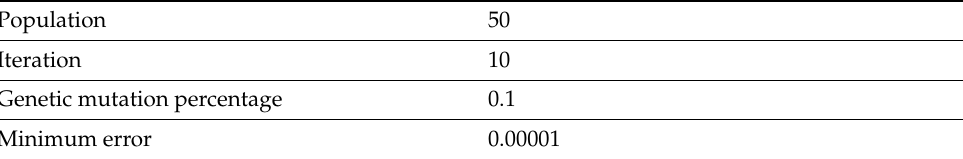
Table 4. GA Designing Parameters.